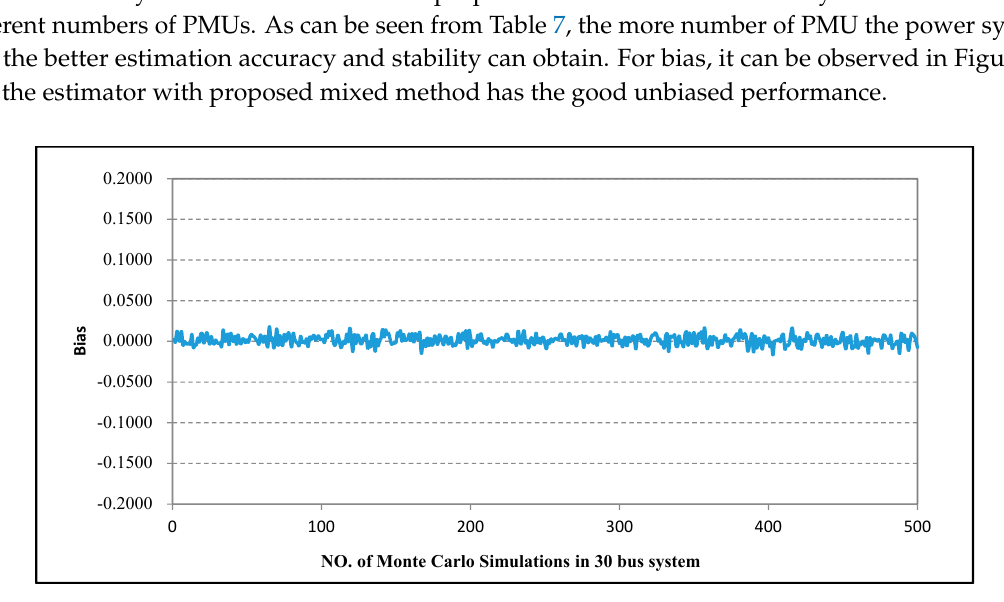
Figure 16. Bias analysis of proposed method in 30 bus system. Table 6. The results of state estimation of four methods in 30 bus system.